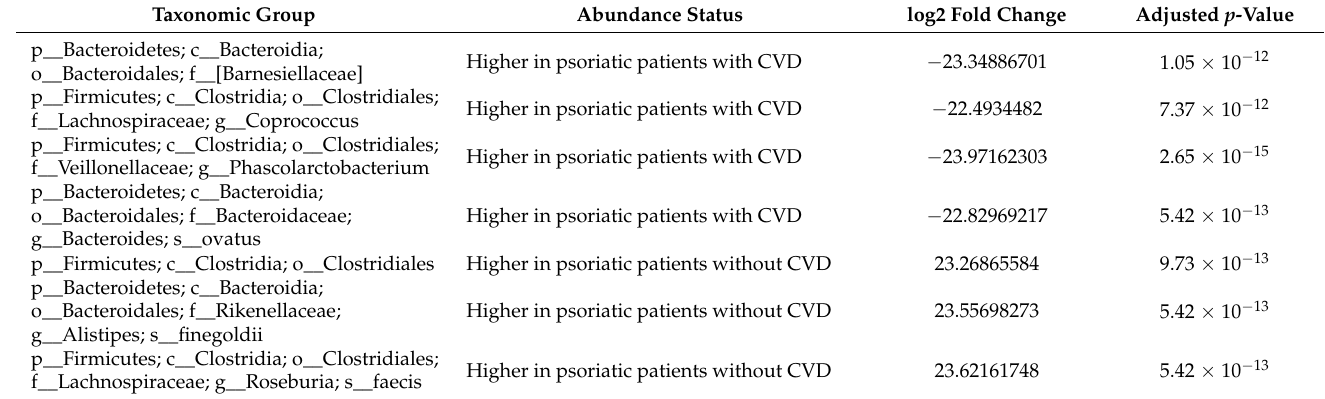
Table 2. List of the significantly differentially abundant taxonomic groups in psoriatic patients with and without CVD.